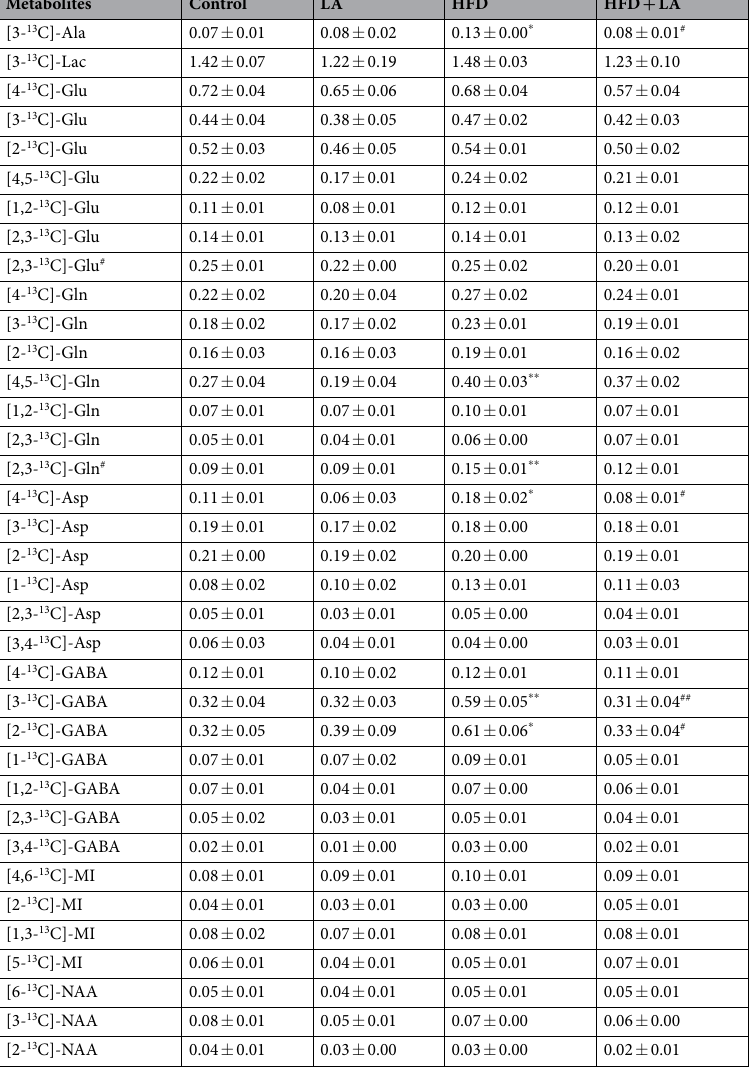
Table 1. Concentration of the different isotopomers of 13 C labeled Ala, Lac, Glu, Gln, Asp, GABA, MI, and NAA after [1- 13 C]-Glucose + [1, 2- 13 C]-Acetate infusion. Concentration of the isotopomers of 13 C g Glu, Gln, Asp, GABA, MI, and NAA in mice fed standard/HFD with/without lipoic acid, after 60 min of [1- 13 C]- Glucose + [1, 2- 13 C]-Acetate infusion. Results in the columns 2–5 are presented as average nmol/mg brain The results for Glu, Gln, GABA, and Asp with single 13 C are corrected for natural abundance (the results for Ala, Lac, MI, NAA, and with 13 C doublets are not corrected for natural abundance). [2,3- 13 C]-Gln/Glu # stand for [2,3 and 3,4- 13 C]-Gln/Glu,